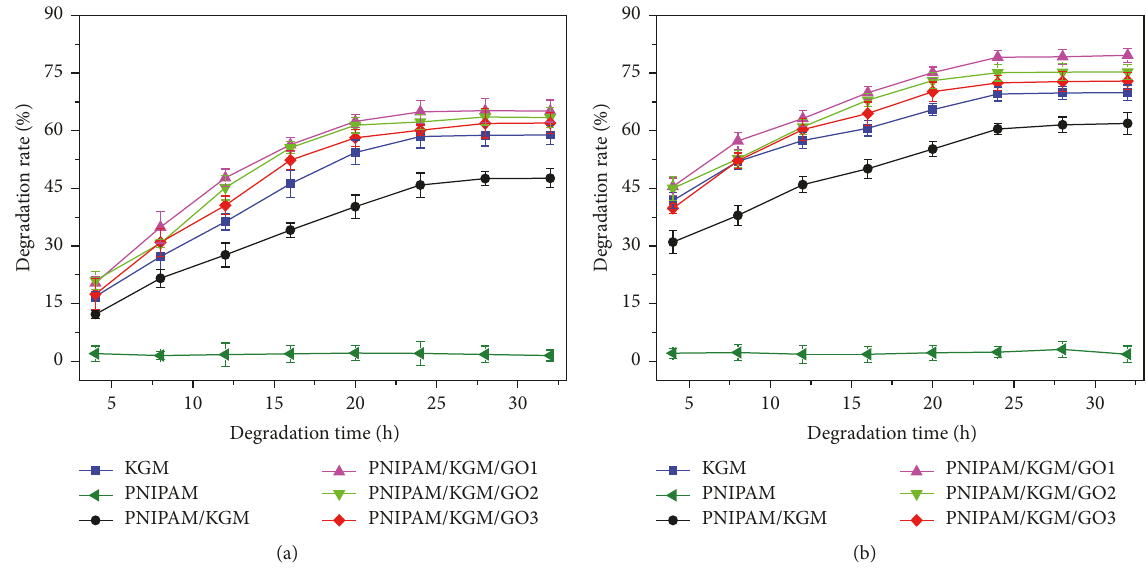
Figure 8: Degradation rate of conventional KGM, PNIPAM, PNIPAM/KGM, and PNIPAM/KGM/GO composite membranes with different amounts of GO in buffer solution of pH 7.40 with 0.2 (a) and 0.4 mg ⋅ mL −1 (b) 𝛽 -mannanase at 37 ∘